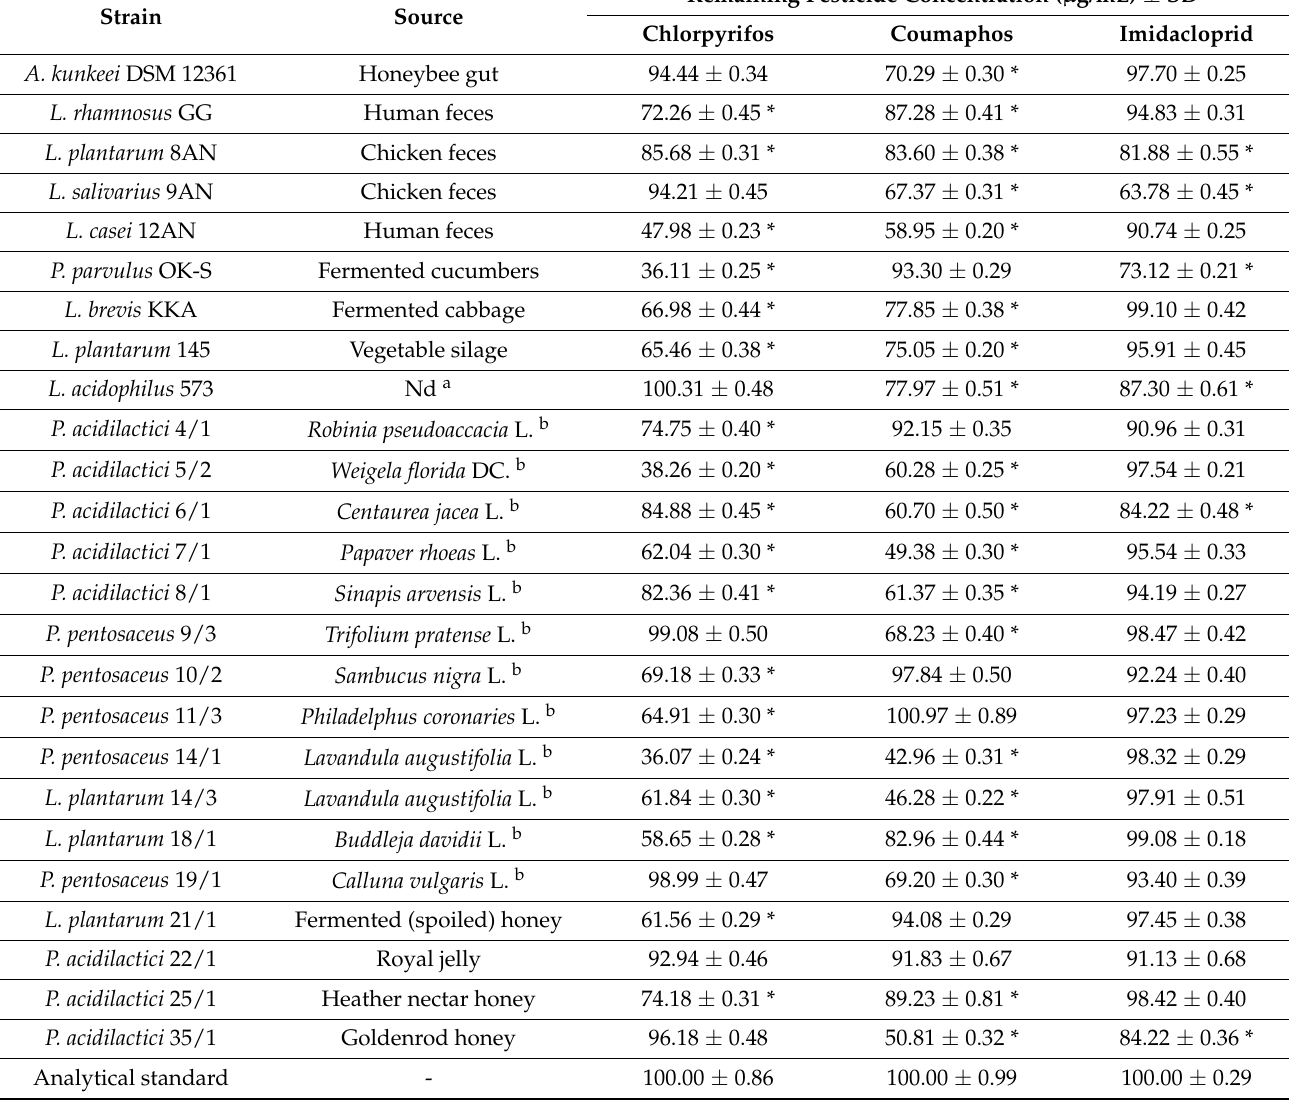
Table 1. The ability of lactic acid bacteria (LAB) strains to bind pesticides to the cell wall. The experiments were conducted for whole live LAB cells. The initial concentration of an individual pesticide was 100 µ g/mL. The presented results are mean from two measurements ± standard deviation (SD). Statistical significance was calculated versus positive control (appropriate pesticide standard, 100 µ g/mL), * p ≤